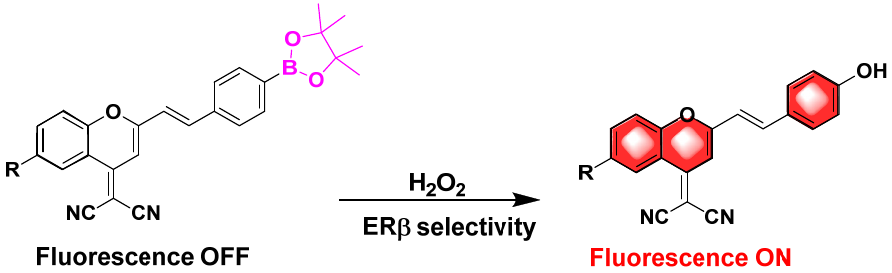
Figure 1. Design of ER β -targeted, H 2 O 2 -triggered NIR probes for prostate cancer study.